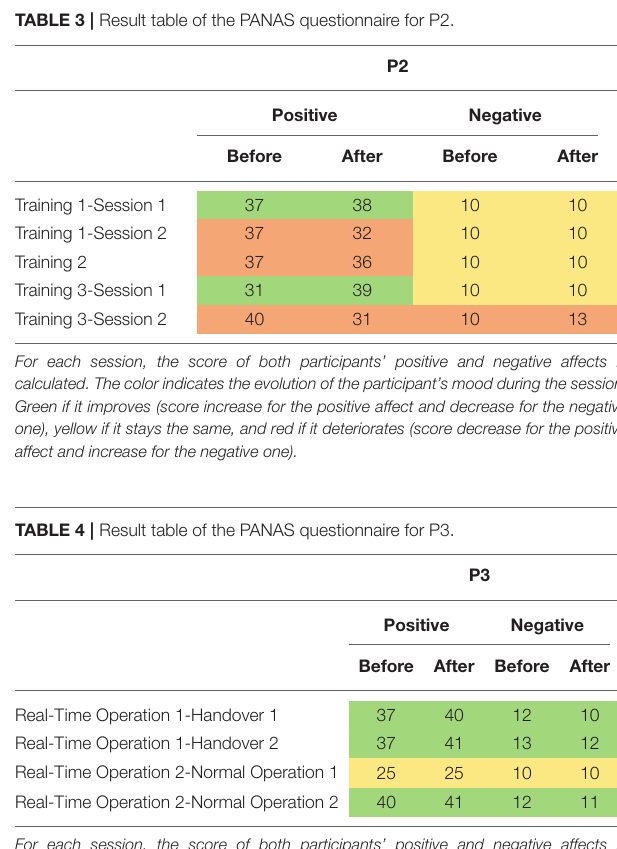
TABLE 3 | Result table of the PANAS questionnaire for P2.